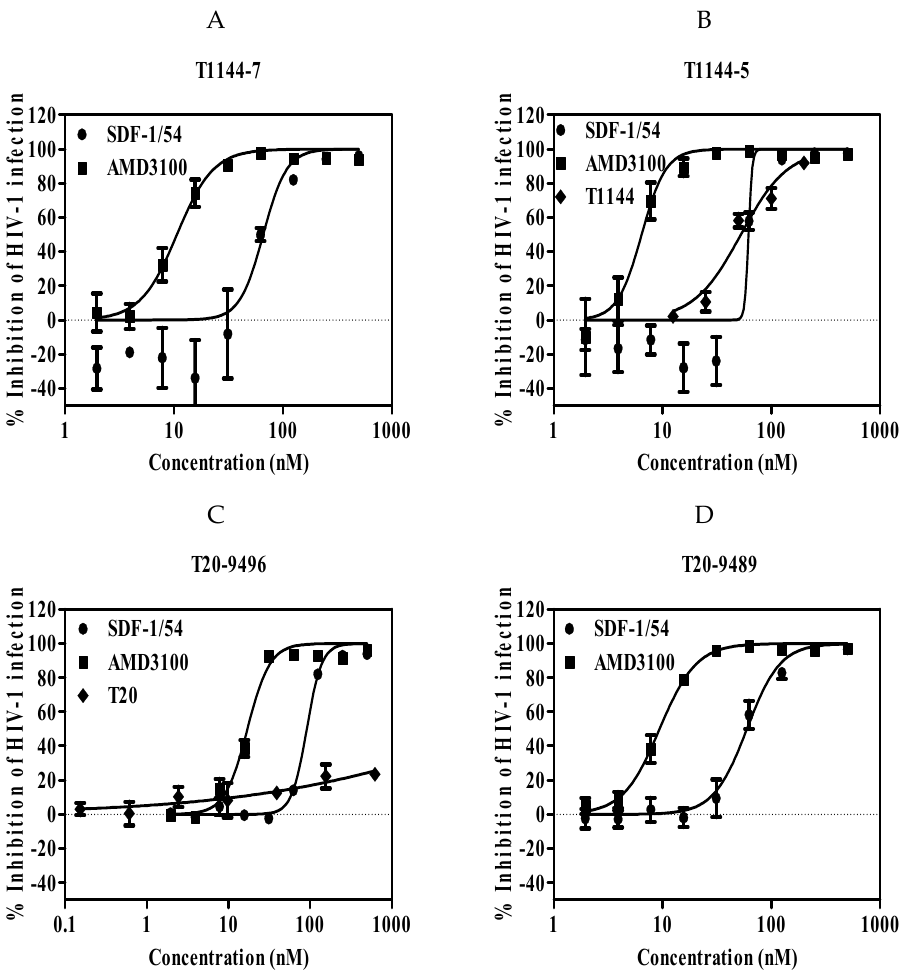
Figure 4. SDF-1/54 is effective against HIV-1 drug-resistant strains. SDF-1/54-mediated inhibition of infection by drug-resistant HIV-1 of TZM-bl cells which included viral strains resistant to T1144 ( A , B ) and T20 ( C , D ). TZM-bl cells were pre-incubated with graded concentrations of SDF-1/54 for 15 min at 37 °C. Then, drug-resistant HIV-1 was added to the mixture. At 48 h post-infection, luciferase activity was detected. Average values (±SD) from three independent experiments are shown. Table 4. The inhibitory activities of SDF-1/54 and AMD3100 on infection by HIV-1 resistant strains Virus Virus strain